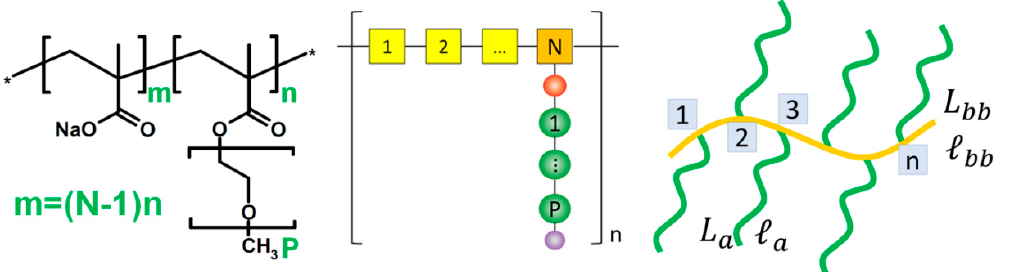
Figure 3. Model structure of comb-like PCE (polyethylene glycol monomethyl ether grafting on poly(methacrylic acid) backbone). Chemical structure ( left ); schematic representation of the comb − like polymer for scaling model ( middle ); schematic representation of a comb-like structure ( right